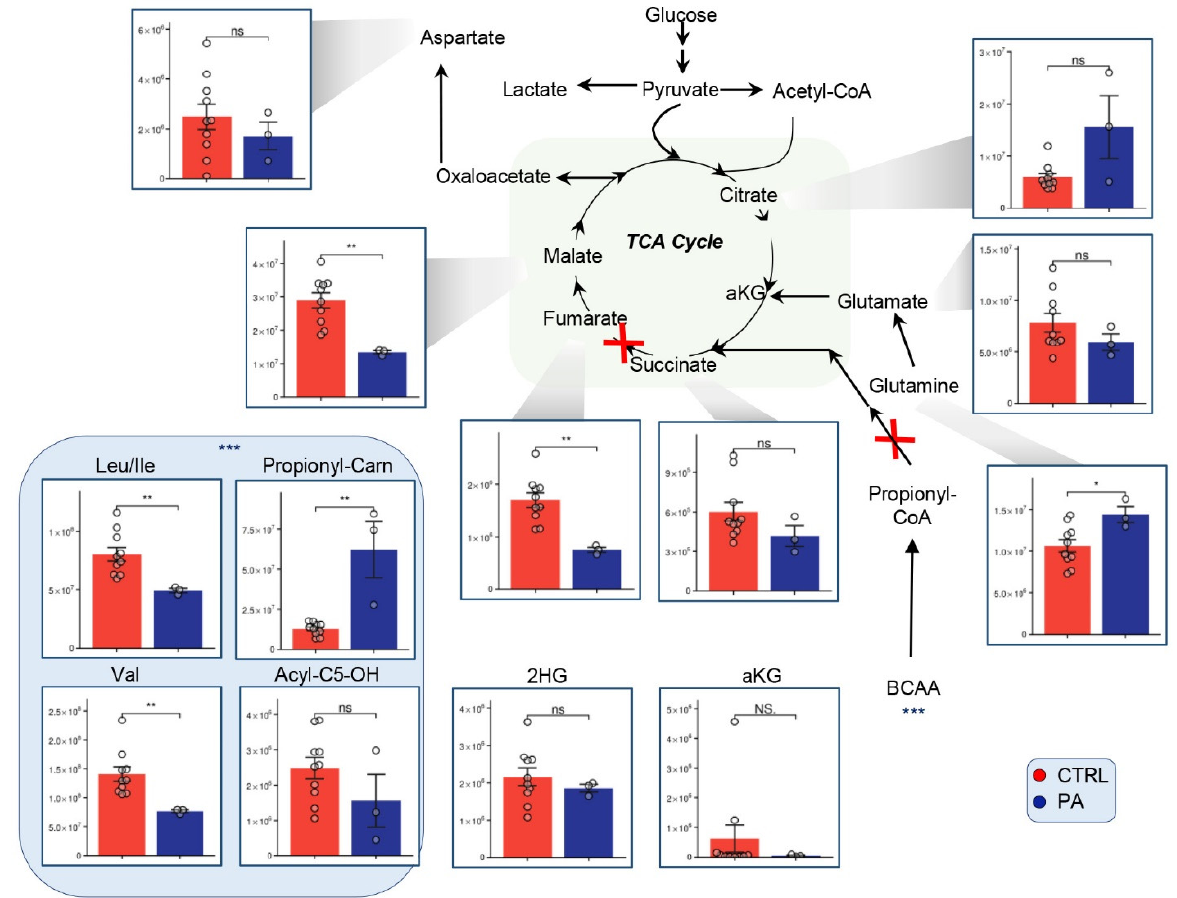
Figure 3. PA alters levels of TCA metabolites and precursors in RBCs. Summary of the tricarboxylic acid cycle (TCA) and related metabolites in PA patients relative to controls. Y-axes represent peak area (arbitrary units). Asterisks indicate significant results, error bars represent ± standard error of the mean (unpaired t -test, 2-tailed distribution, * p < 0.05, ** p < 0.01, *** p <